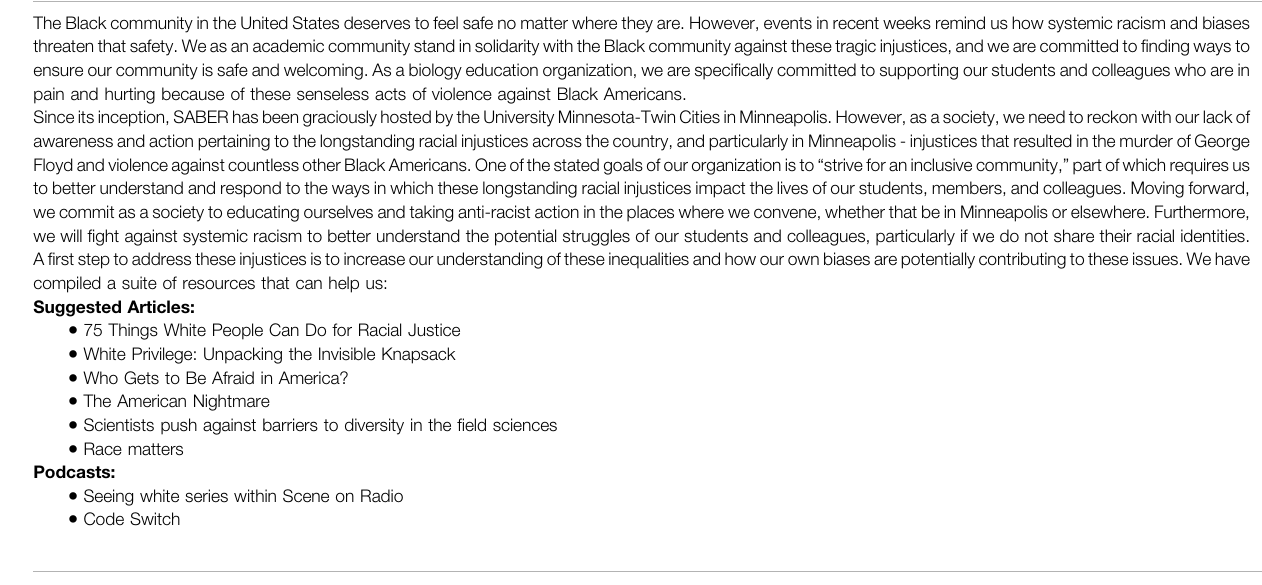
TABLE 2 | Statement of solidarity with the Black community. The Black community in the United States deserves to feel safe no matter where they are. However, events in recent weeks remind us how systemic racism and biases threatenthatsafety. Weasanacademiccommunity standinsolidaritywiththeBlackcommunityagainstthesetragicinjustices,andwearecommittedto fi ndingwaysto ensure our community is safe and welcoming. As a biology education organization, we are speci fi cally committed to supporting our students and colleagues who are in pain and hurting because of these senseless acts of violence against Black